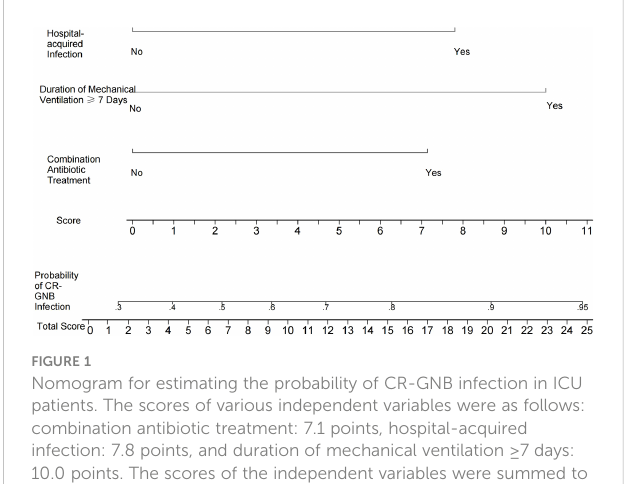
FIGURE 1 Nomogram for estimating the probability of CR-GNB infection in ICU patients. The scores of various independent variables were as follows: combination antibiotic treatment: 7.1 points, hospital-acquired infection: 7.8 points, and duration of mechanical ventilation ≥ 7 days: 10.0 points. The scores of the independent variables were summed to obtain the overall score, which can be used to predict the probability of CR-GNB infection in ICU patients. For instance, the predicted probability of CR-GNB infection occurrence in ICU patients was >80% when the total score was >16 points.